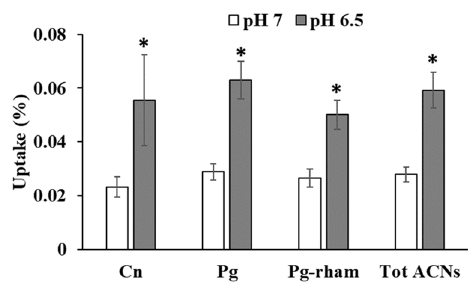
Figure 6. The increase in strawberry anthocyanin uptake with decreasing pH from pH 7 to 6.5 at a concentration of 10 µM anthocyanins. Cn (Cyanidin-3-glucoside), Pg (Pelargonidin-3-glucoside), Pg-rham (Pelargonidin-3-rhamnosylglucoside), Tot ACN (Total anthocyanins). * significant at p < 0.05 .